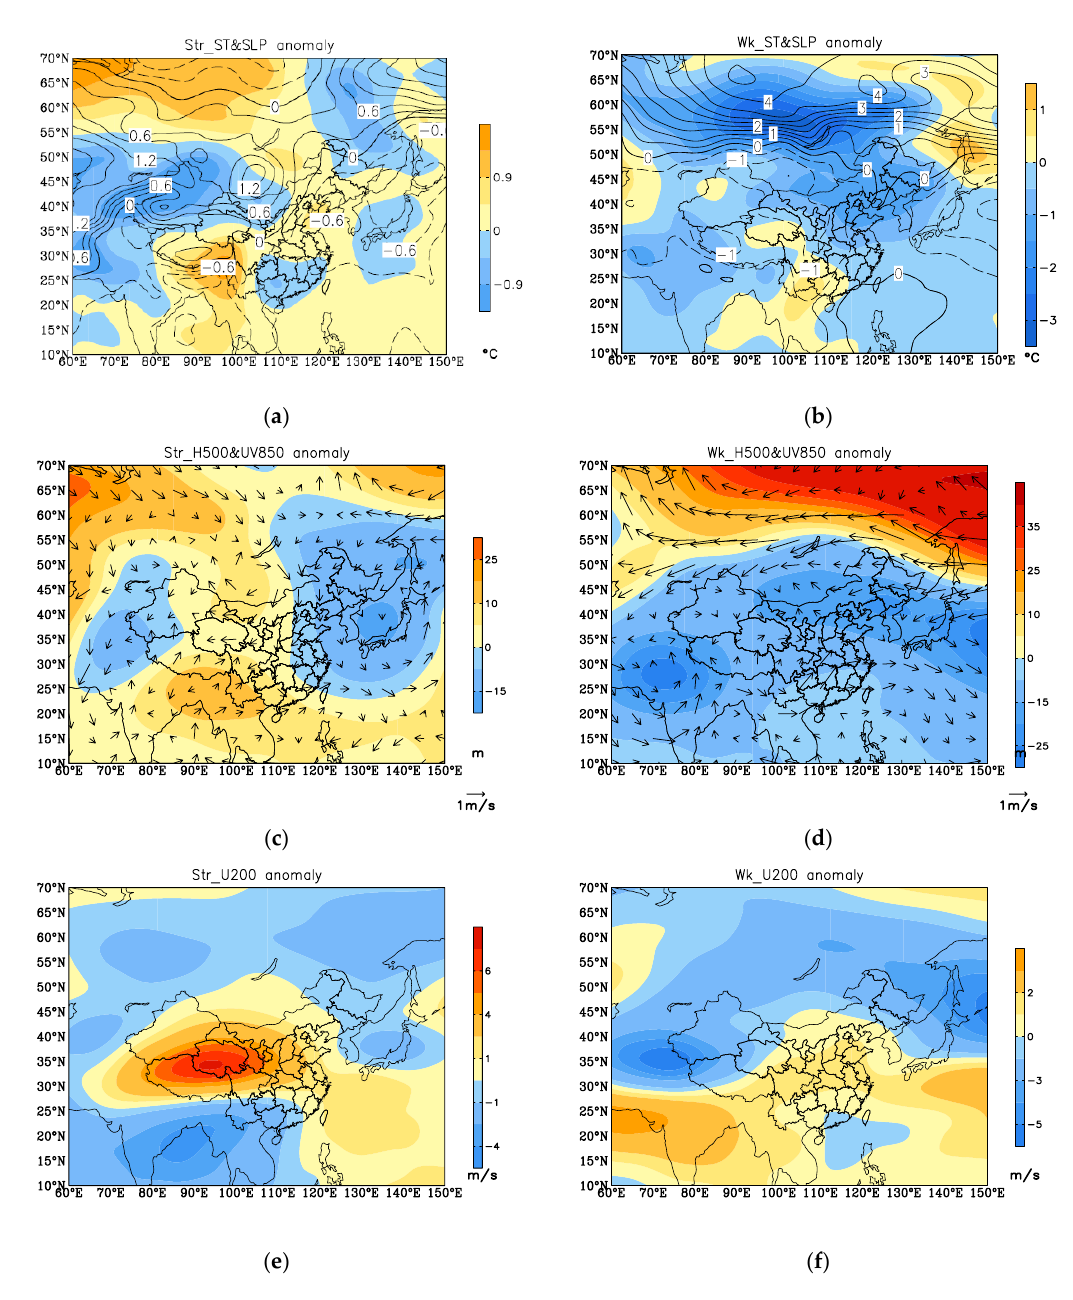
Figure 5. Sea level temperature and air pressure ( a , b ), units ( ◦ C and Pa), 850 hPa uv wind and 500 hPa potential height ( c , d ), units (m / s and m), 200 hPa latitudinal wind speed ( e , f ), units (m / s) in Q 1 strong and weak year and their di ff erences (strong–weak year). ( a , c , e ) for a strong year, ( b , d , f ) for a weak year.